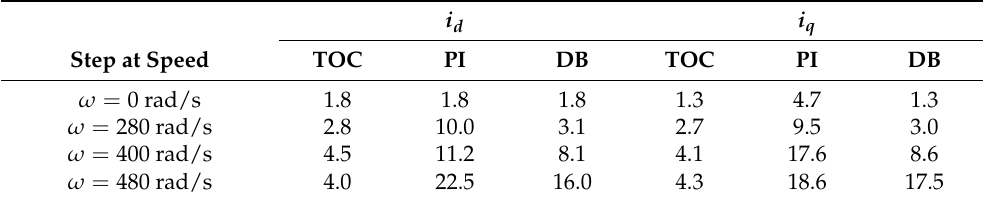
Table 2. Comparison of settling time of different controllers for the transients in Figure 8. All times are given in milliseconds. i d i q Step at Speed TOC